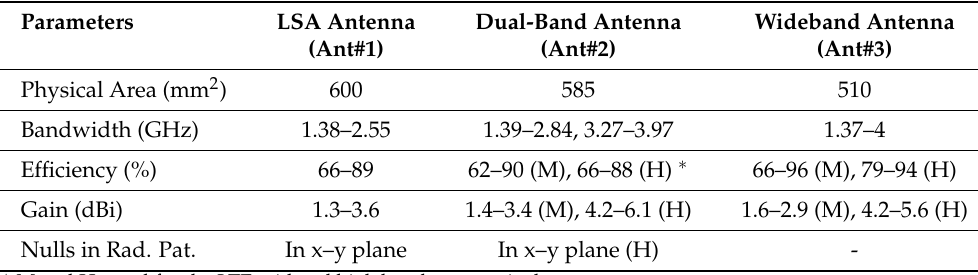
Table 3. Performance comparison of the presented LSA (Ant#1), dual-band (Ant#2), and wideband (Ant#3) antennas.